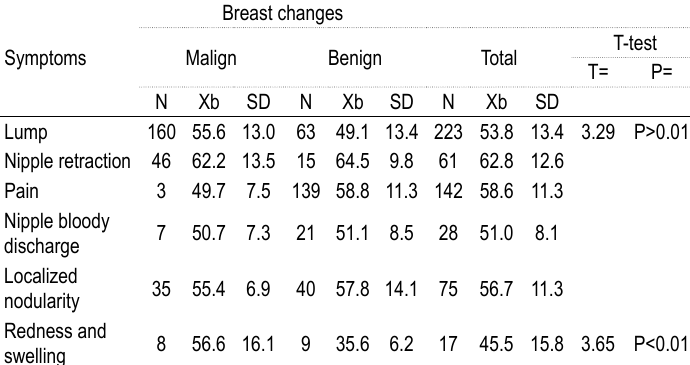
Table 4. breast symptoms according to patient age – statistical parameters